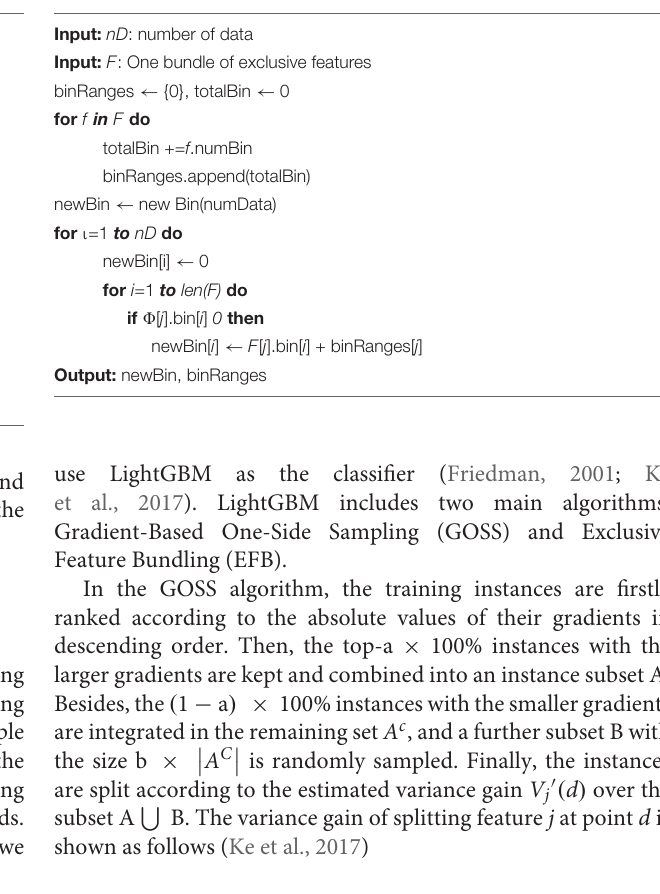
ALGORITHM 1 | Greedy bundling. ALGORITHM 2 | Merge exclusive features.